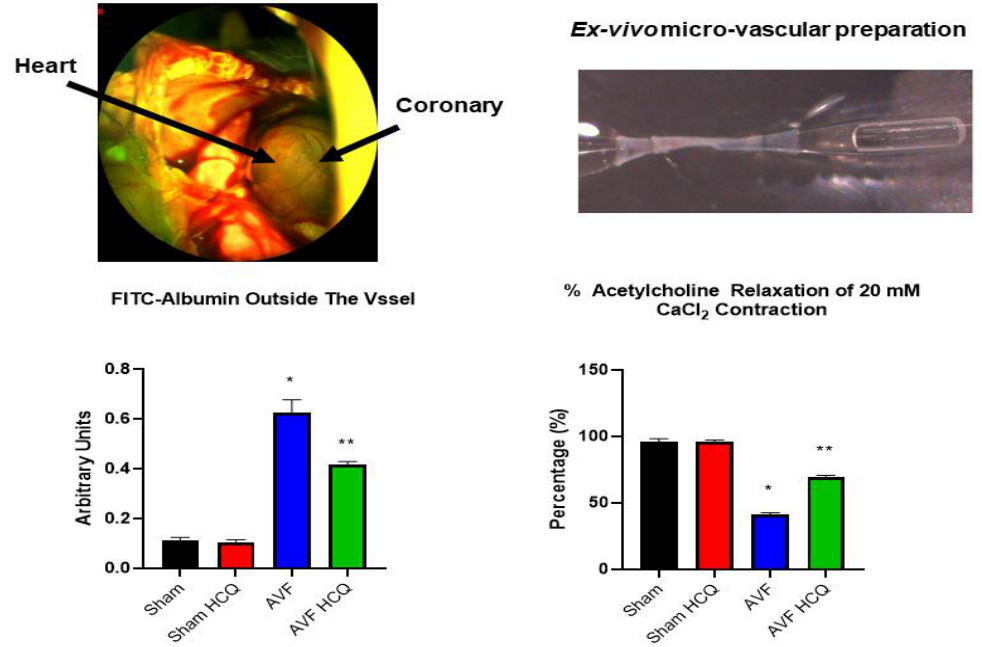
Figure 8. Ex vivo coronary vascular preparation and measurements of the vascular leakage and reactivity. The left upper panel shows a whole heart perfused with FITC; the right panel shows an isolated cannulated perfused vessel. The lower left bar graph represents FITIC florescence outside the perfused vessel. The right bar graph represents endothelial-dependent acetylcholine response to the coronary vessel, from AVF and sham mice with and without the HCQ treatment. *, <0.05 compared with sham, **, <0.05 compared with AVF; n = 5–8 in each group.